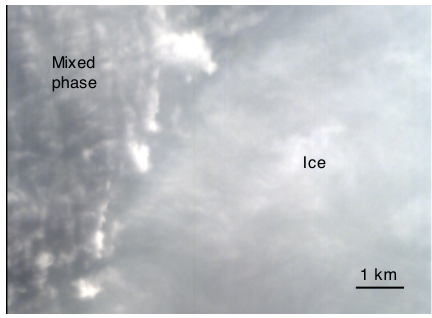
Figure 3. Thermodynamic phase map corresponding to Fig. 2, with green indicating equivalent liquid thickness and blue indicating equivalent ice thickness.